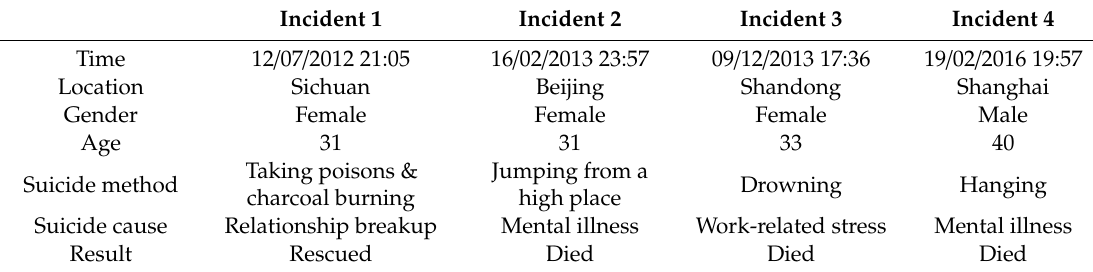
Table 1. Details of suicide incidents.